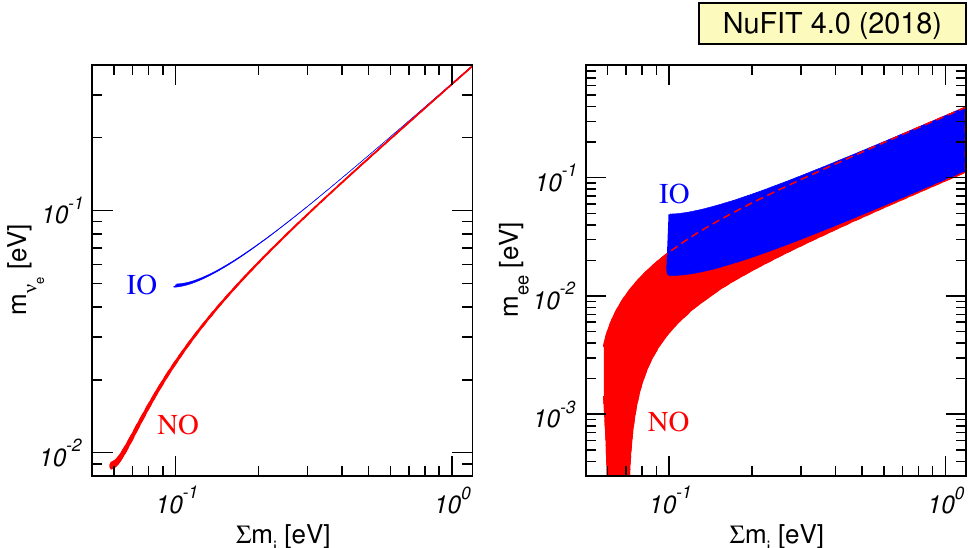
, P m (cid:23) ) and ( m ee , P m (cid:23) ) obtained e